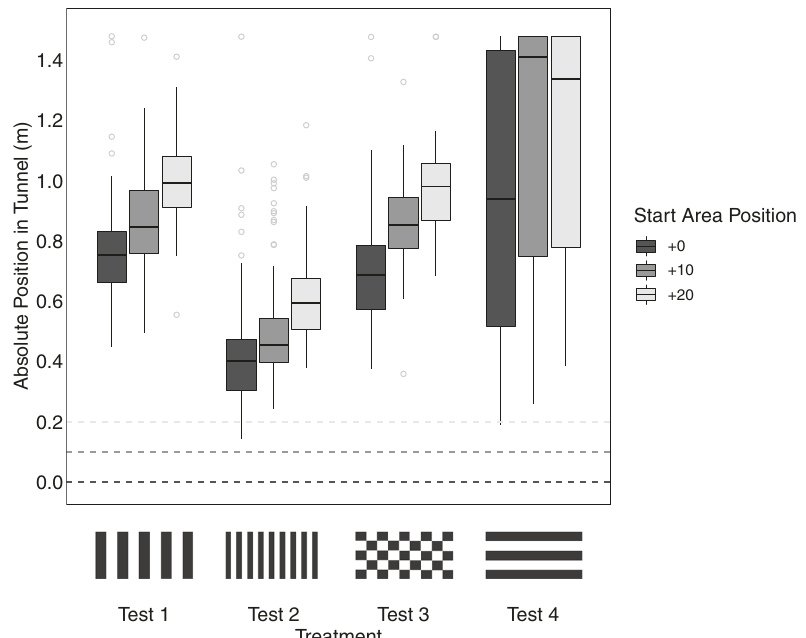
Fig. 3 Absolute turning positions across treatments. Between sessions, the start area was moved across three increasingly distal positions within the tunnel to control for the use of external cues and assess distance estimation abilities. If fi sh were using an internal measure of distance, there would be a systematic shift in turning position according to each start area position. This was indeed observed across treatments 1 – 3 where spatial frequency information was provided, indicating that fi sh are reporting perceived travel distance. When spatial frequency information was removed in treatment 4, there was no consistent signi fi cant shift in turning position for all start area positions. Grey dashed lines indicate corresponding start area positions for the three start area positions (dark grey: + 0; mid grey: + 10; light grey: + 20). Box plots indicate the median, interquartile range, and grey points indicate outliers. Each fi sh completed a maximum of 15 distance estimates for each start area position.